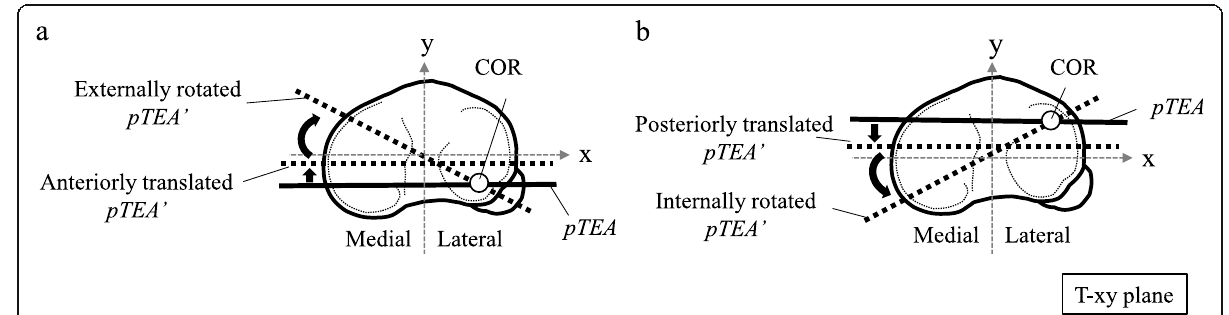
Fig. 1 COR estimation during walking. The projected transepicondylar axis of the femur on the tibial x-y plane was defined as the pTEA (solid line). The pTEA ’ (dotted line) was defined as the change in pTEA after knee motion. The COR was defined as the intersection of pTEA and pTEA ’ . When the pTEA translated anteriorly and rotated externally, the COR was lateral, that is, lateral pivot ( a ). When the pTEA translated posteriorly and rotated internally, the COR was lateral ( b ). COR, center of axial